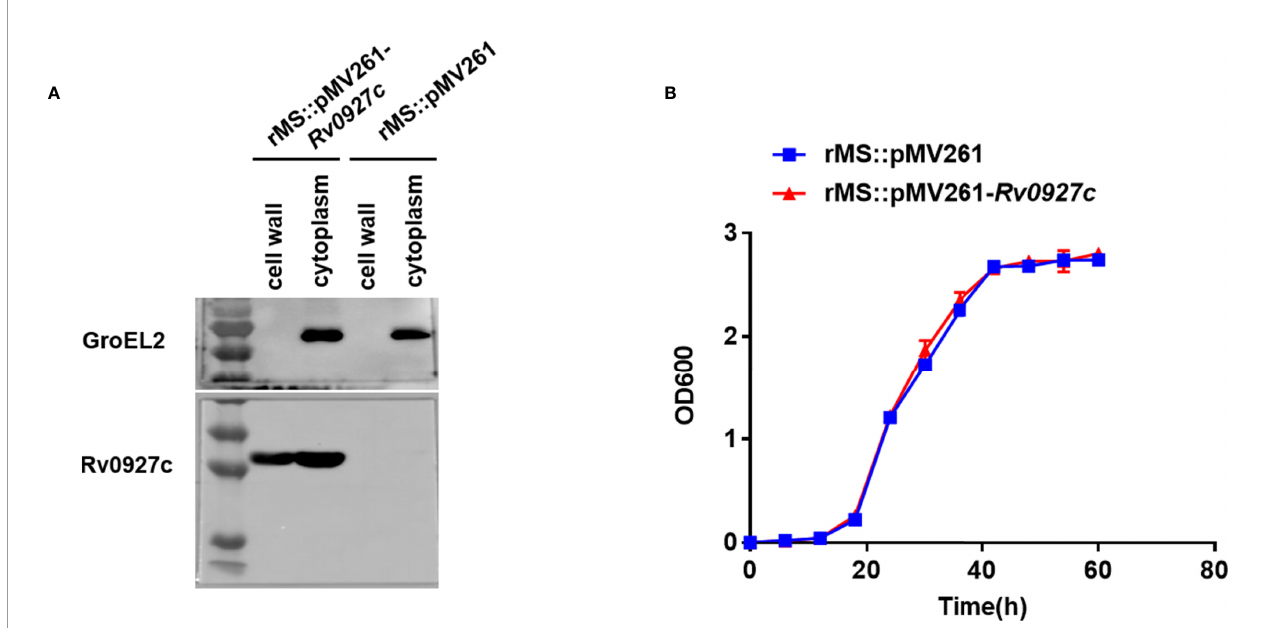
FIGURE 1 | Subcellular localization and bacterial growth. (A) Cell fractionations were prepared and subjected to Western blot to detect the subcellular localization of Rv0927c in rMS::pMV261- Rv0927c . The cytoplasm marker of Mycobacterium tuberculosis GroEL2 served as a control. (B) Growth curves were determined for rMS::pMV261 and rMS::pMV261- Rv0927c cultivated in 7H9